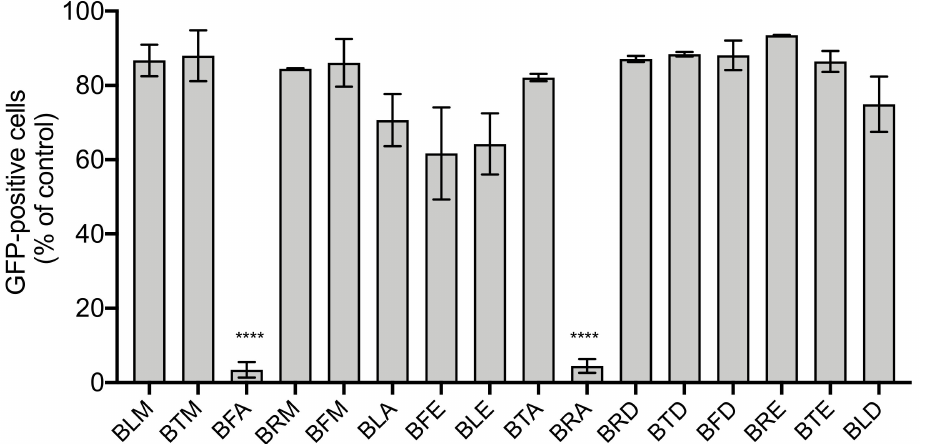
Figure 2. BFA and BRA exert antiviral activity against ZIKV. A549 cells were infected with ZIKV GFP at MOI of 2 in the presence of B. gymnorhiza extracts at 200 µ g/mL. After 24 h of infection, flow cytometric analysis of GFP fluorescence was conducted. The results are given as means ± SD of three independent experiments and expressed as relative values in contrast to untreated infected cells. **** p < 0.0001 indicates significant differences in the